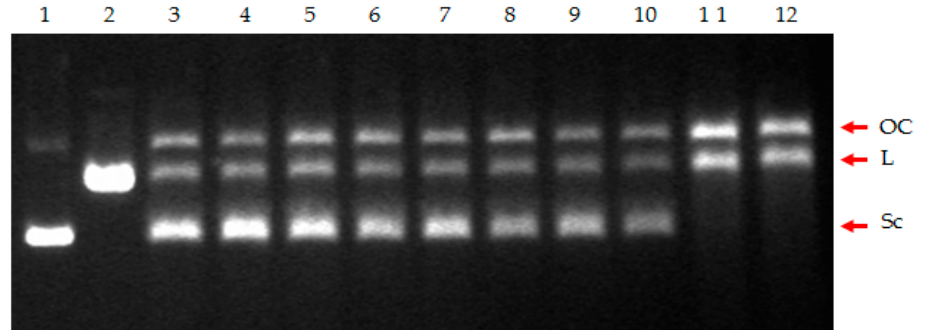
Figure 7. Cleavage assay of the supercoiled pBR322 plasmid DNA in the presence of S. aureus Topo IV and the tested compounds. Lane 1, supercoiled plasmid (control); lane 2, linearized plasmid (control); lane 3, no drug (control); lane 4, compound 4 (0.1 µM); lane 5, compound 4 (10 µM); lane 6, compound 4 (100 µM); lane 7, compound 7 (0.1 µM); lane 8, compound 7 (10 µM); lane 9, compound 7 (100 µM); lane 10, norfloxacin (0.1 µM); lane 11, norfloxacin (10 µM); lane 12, norfloxacin (100 µM). The position of nicked (OC), linear DNA (L), and supercoiled DNA (Sc) is indicated.